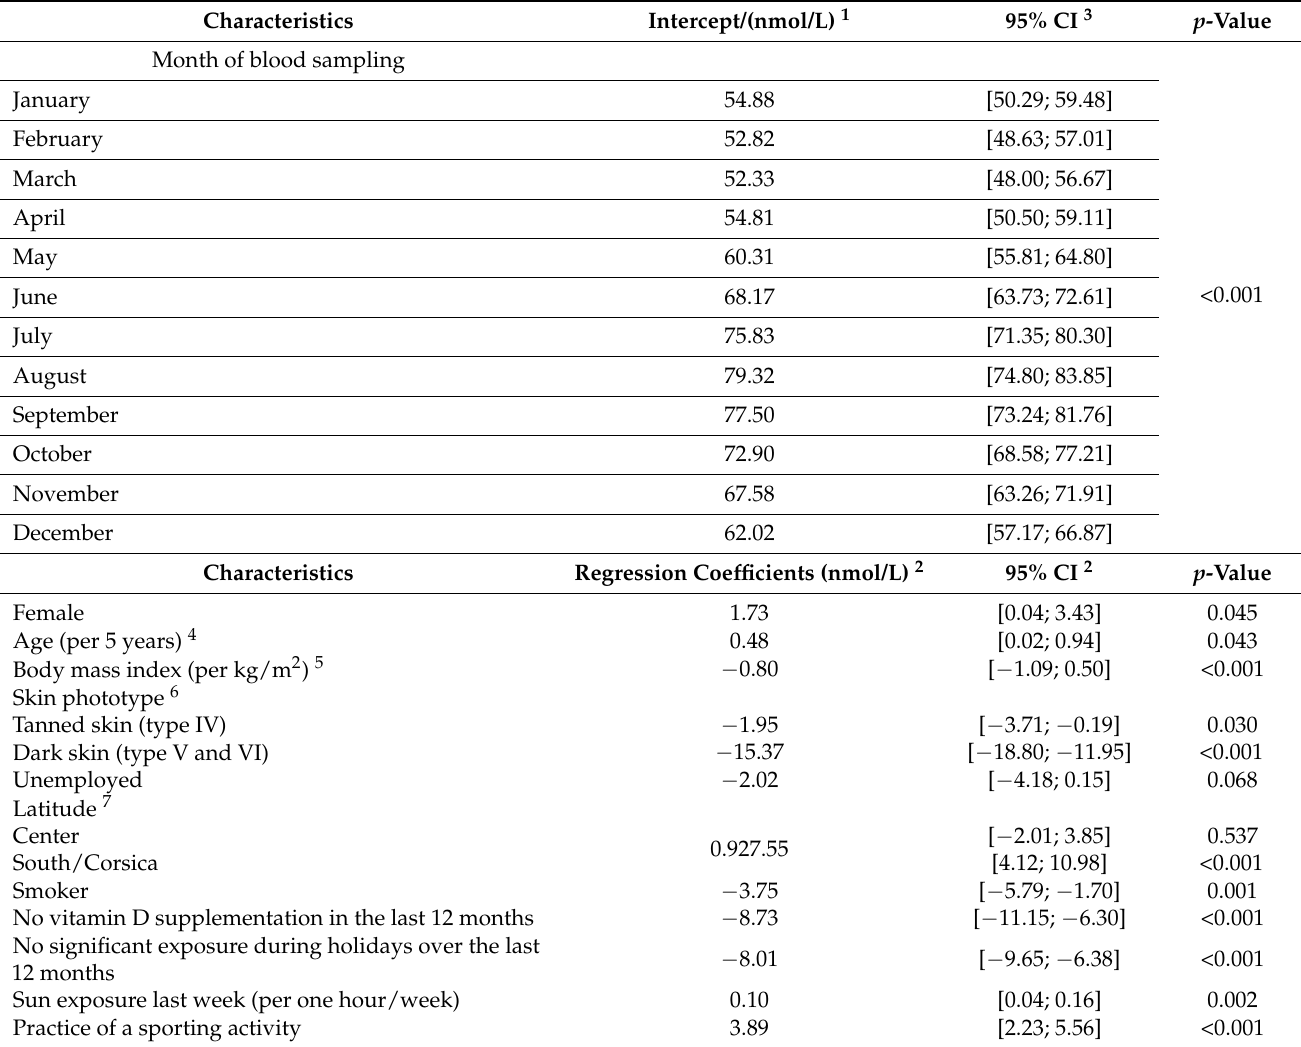
(Table 3). The vitamin D concentration tended to decrease with age until 40–50 years and to be higher for older age classes. It tended to be maximal for BMI values around 20 and lower for values below and above 20 (Figure 3). Participants with dark skin (type V and VI) had serum vitamin D concentration 15.37 nmol/L lower than participants with light-colored skin (type I to III), and participants with tanned skin (type IV) had serum vitamin D concentration 1.95 nmol/L lower than participants with light-colored skin (type I to III). Smokers had vitamin D concentration on average 3.75 nmol/L lower than non-smokers, and unemployed participants had vitamin D concentration 2.02 nmol/L lower than participants who were either employed or retired. Participants who had no significant sun exposure during holidays over the preceding 12 months had vitamin D concentration 8.01 nmol/L lower than participants who had, and participants who practiced any sport had vitamin D concentration on average 3.89 nmol/L higher than those who did not (Table 3). Overall, the final model explained 28% of the total variance in vitamin D concentration (0.282, 95% CI (0.238; 0.324)). Table 3. Multivariable regression model with 25(OH)D concentration as dependent variable (n = 2368).